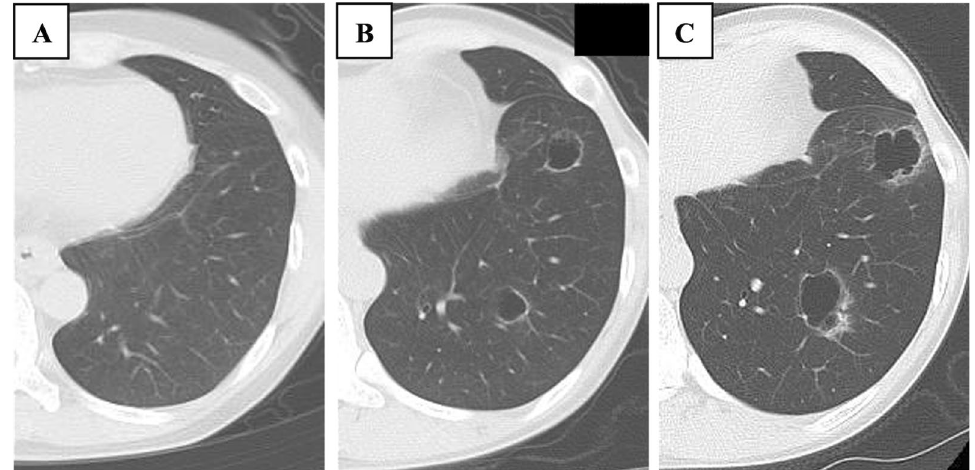
Fig. 2 Changes on plain chest computed tomography. The cysts gradually enlarged and their walls were thickened. A 2 years after the initial surgery, B 3 years after the initial surgery, and C 3 years and 6 months after the initial